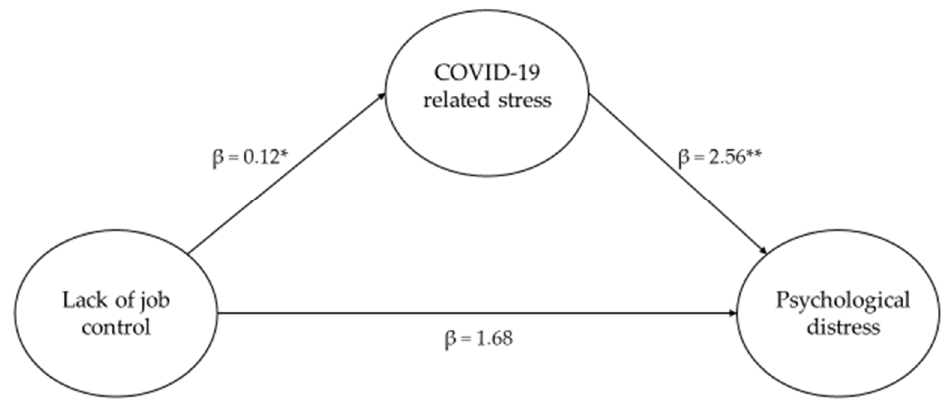
Figure 4. COVID-19-related post-traumatic stress as a mediator between lack of job control and psychological distress. Note: N = 275, ** p < 0.01, * p < 0.05. psychological distress. Note: N = 275, ** p < 0.01, * p < 0.05.